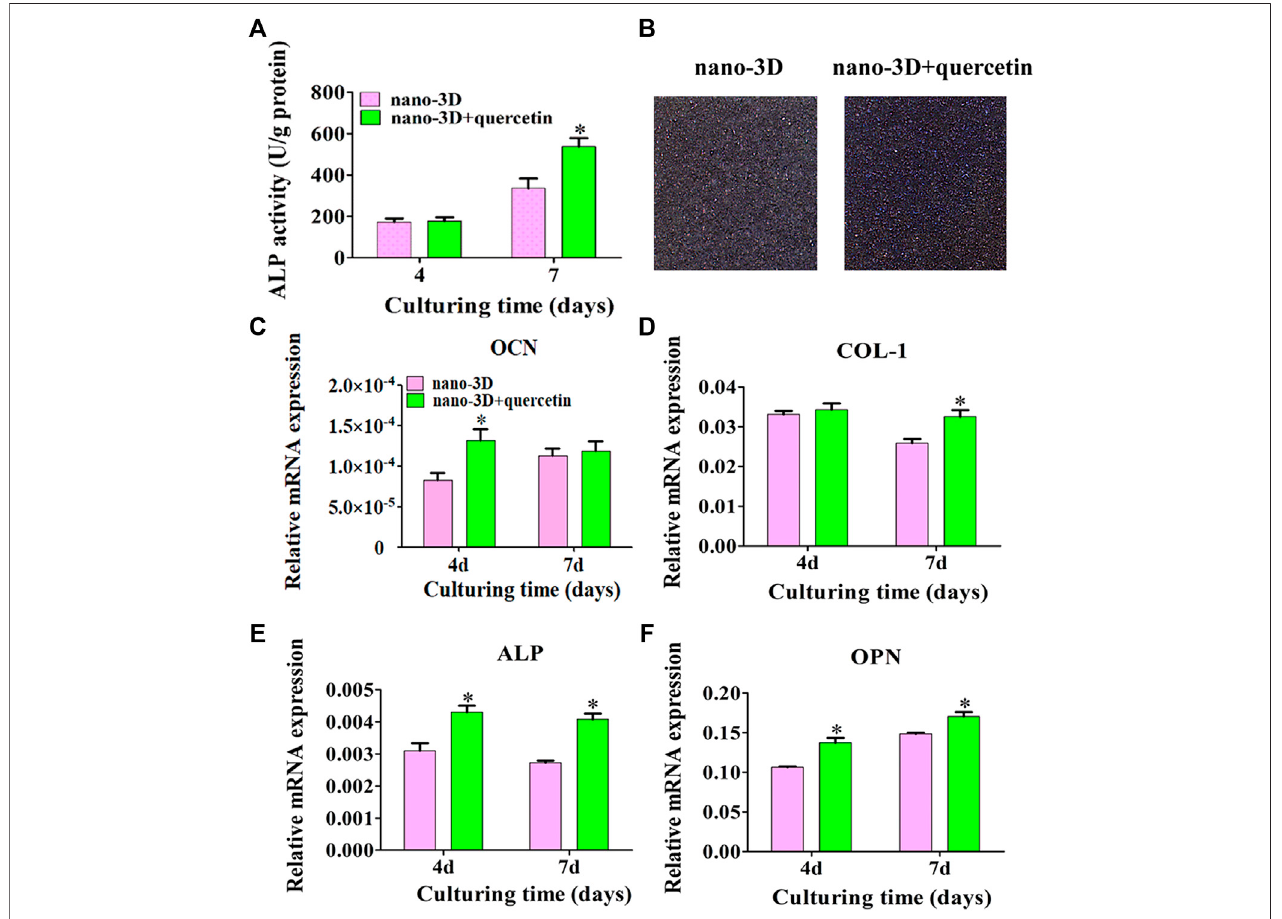
FIGURE 4 | ALP activity at 4/7 days (A) and staining at 7 days (B) of rBMSCs on nano-3D and nano-3D + quercetin sheets; Expression levels of OCN (C) , COL- I (D) , ALP (E) and OPN (F) in rBMSCs cultured on nano-3D and nano-3D + quercetin sheets at 4/7 days (* p < 0.05).